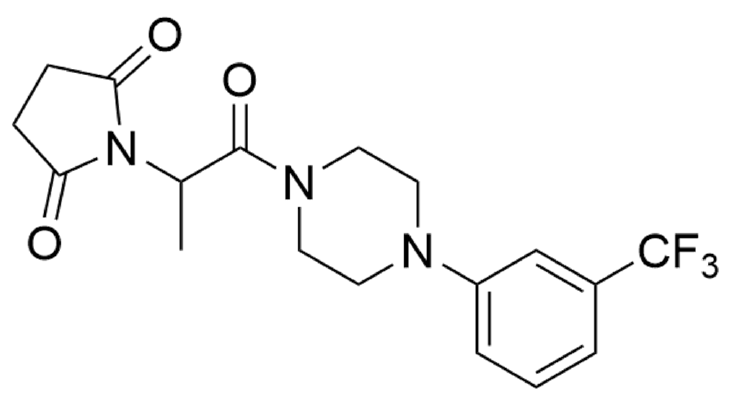
Figure 1. Structural formula of 2-(2,5-dioxopyrrolidin-1-yl) propanamide derivative (C-11).